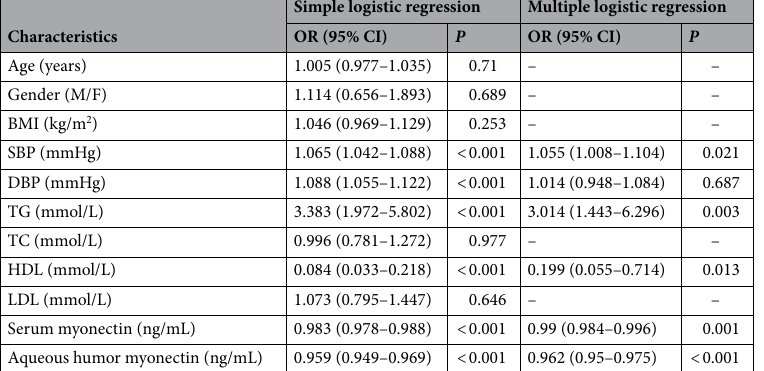
Simple logistic